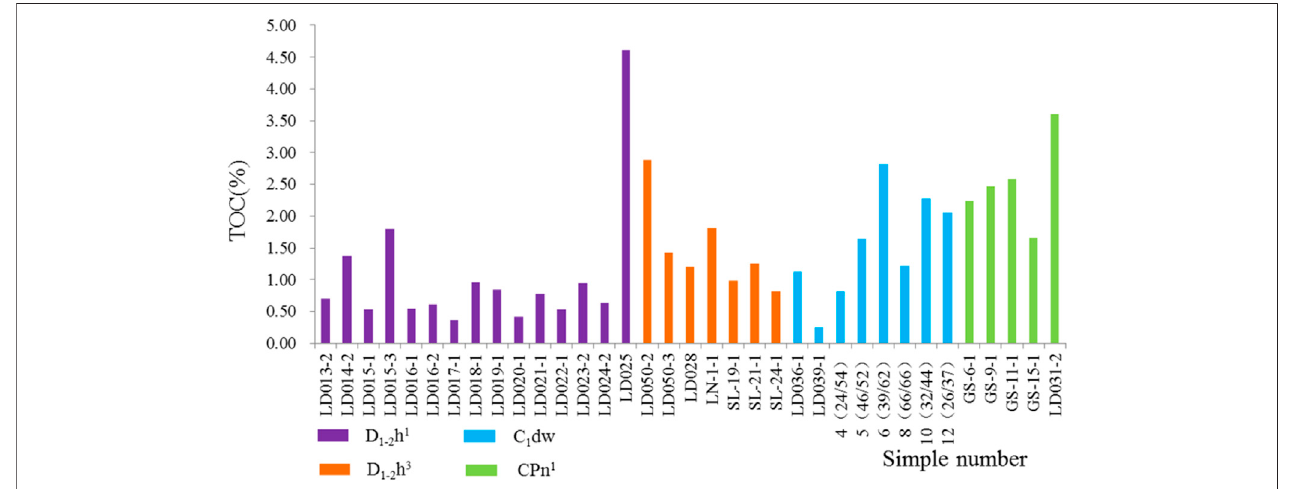
FIGURE 3 | Distribution map of the shale organic carbon content in different horizons in the Qiannan area.